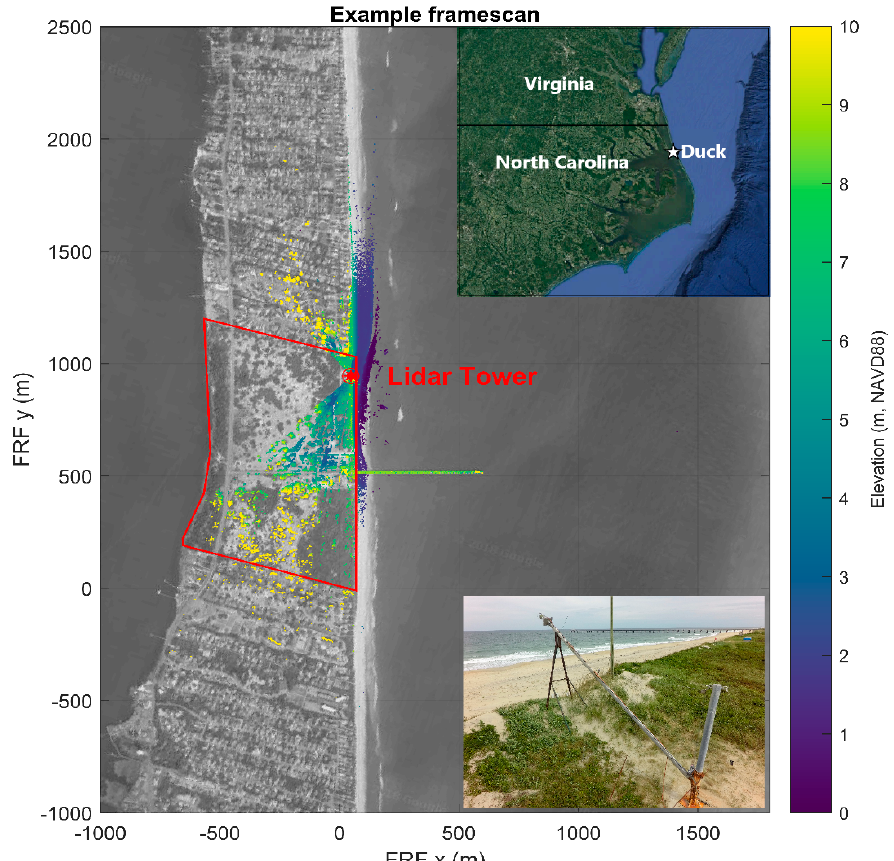
Figure 1. An example framescan overlaid on a Google Earth aerial image with the FRF property outlined in red. A map showing the location of Duck, NC on the Atlantic coast of the United States is shown in the upper right corner, and a photograph of the lidar scanner set-up is shown in the lower right corner. The location of the lidar scanner is shown with a red circle.